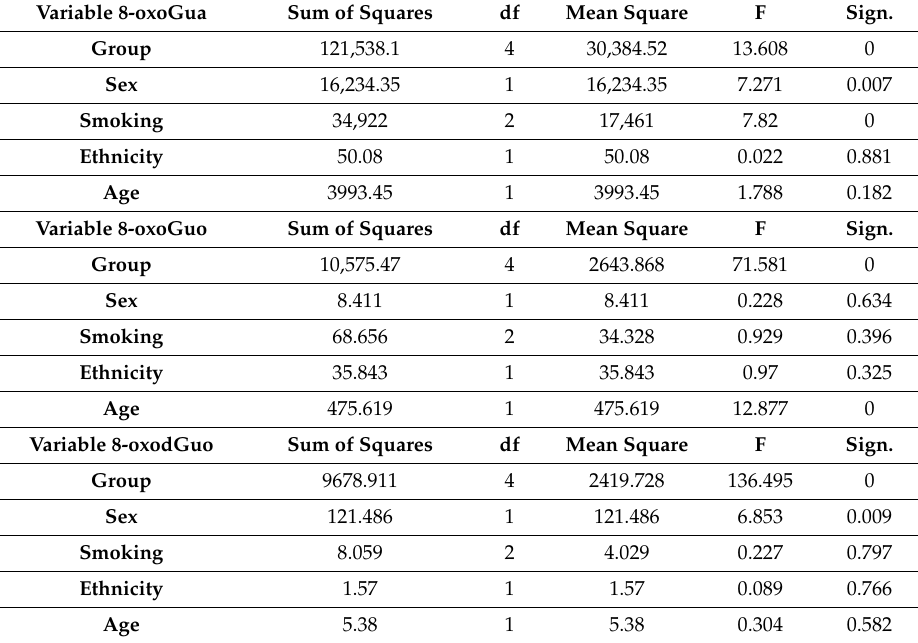
Table 4. ANOVA results for the three oxidative stress